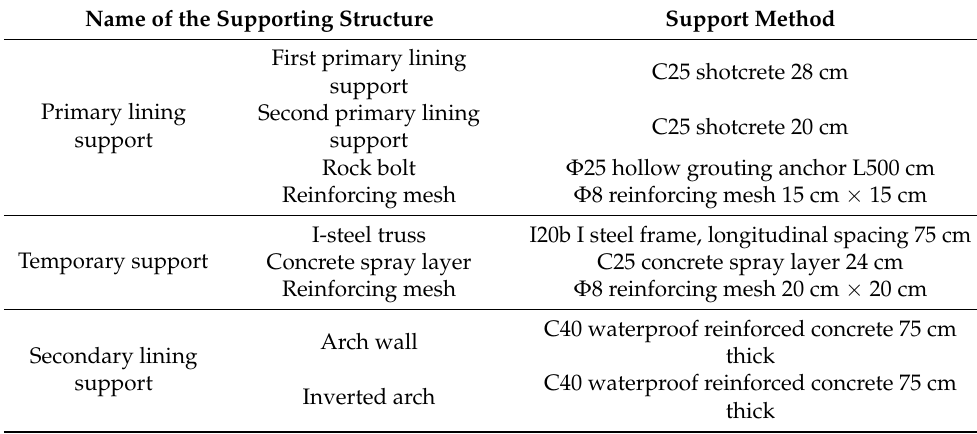
Figure 2. Schematic of the double-side heading method (unit: m). Table 1. Large section supporting structure parameters.